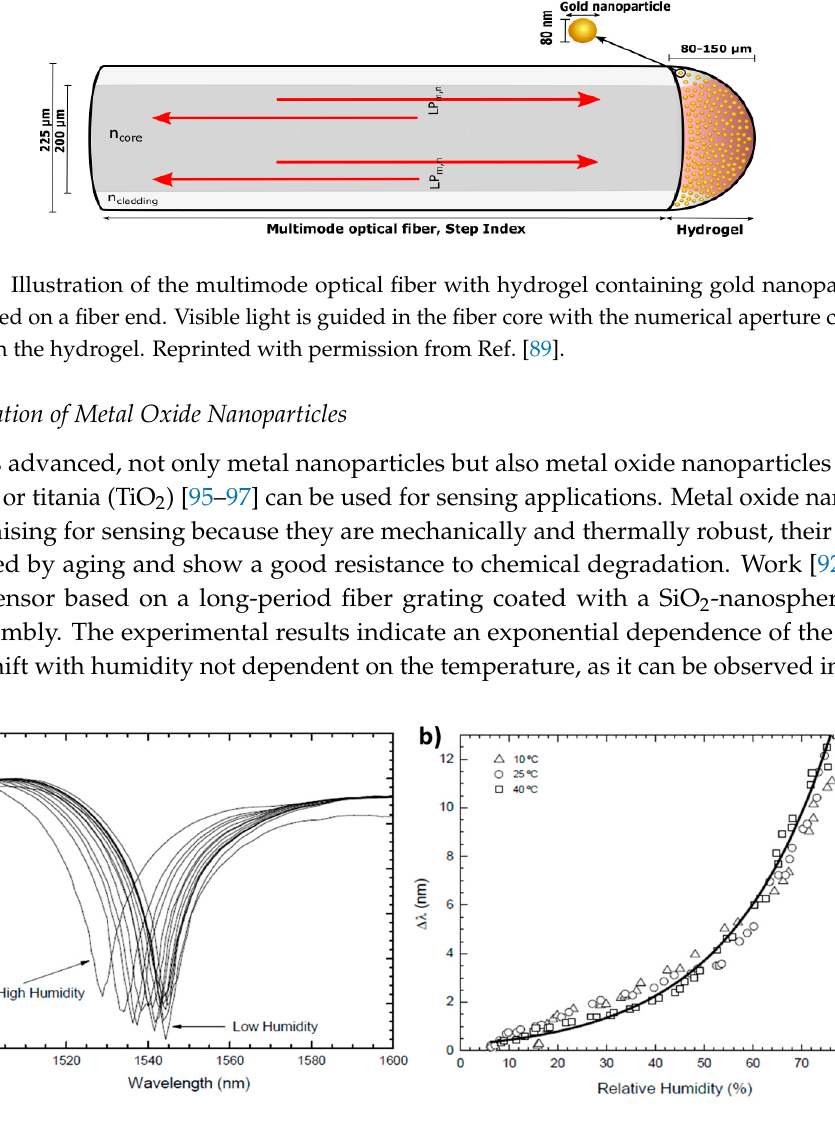
Figure 15. ( a ) Experimental results for different relative humidity levels; ( b ) Relative resonance wavelength shift with relative humidity levels for different temperature values. Reprinted with permission from Ref. [92].